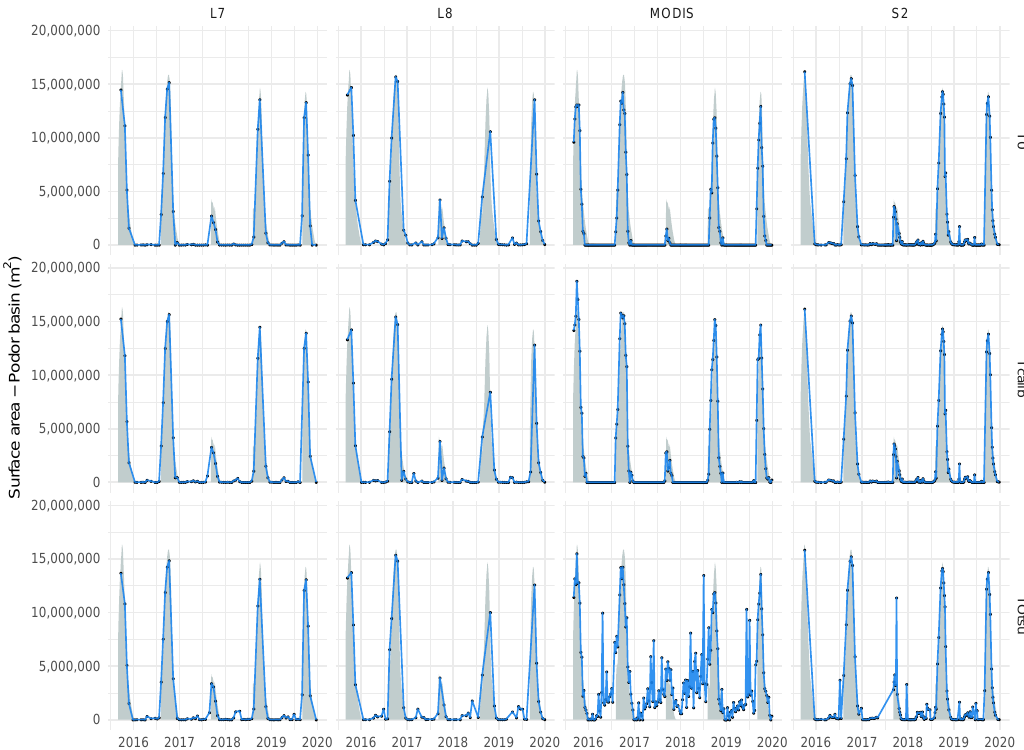
Figure 10. Comparison of remotely sensed flooded areas for each method and sensor (blue lines) against ground truth data (grey areas)